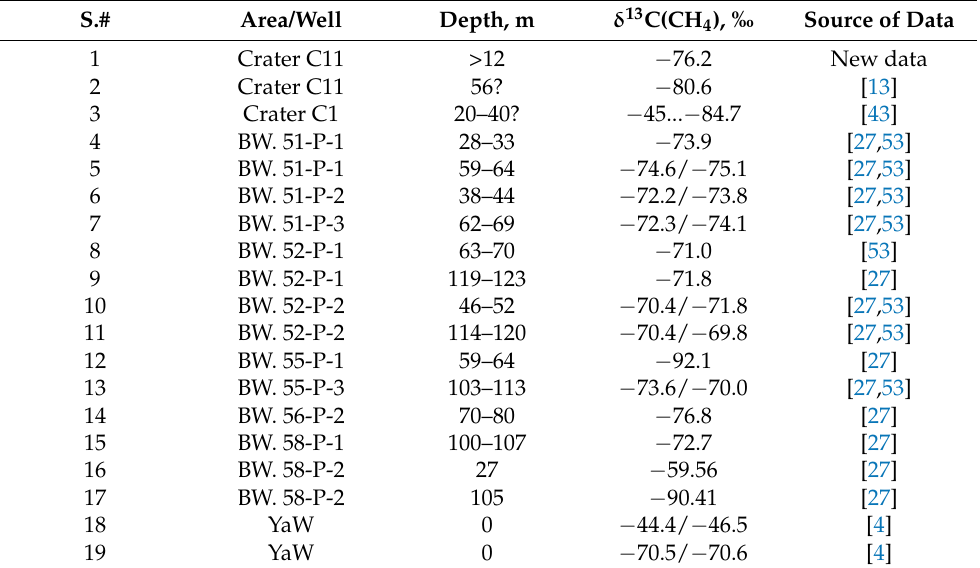
Table 4. Comparison of the stable carbon isotope contents in methane from crater C11 and free gases in the Bovanenkovskoye and Yamburgskoye HC fields (based on [4,13,27,53,78]). S.# Area/Well Depth, m δ 13 C(CH 4 ), ‰ Source of Data Crater C11 Crater